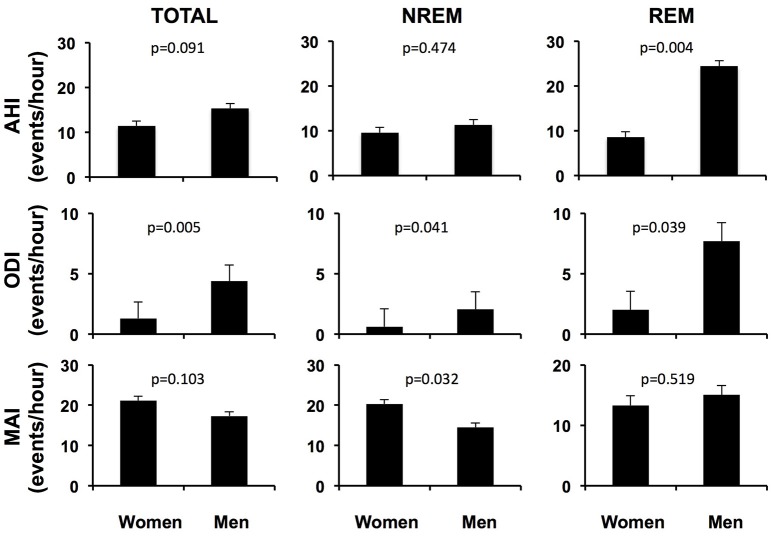
Adjusted respiratory variables and microarousal index of men and women with OSA over the entire night, in NREM sleep and in REM sleep. AHI apnea-hypopnea index; ODI oxygen desaturation index; MAI microarousal index; NREM non rapid eye movement sleep; REM rapid eye movement sleep. Adjusted for age, BMI and race/ethnicity.